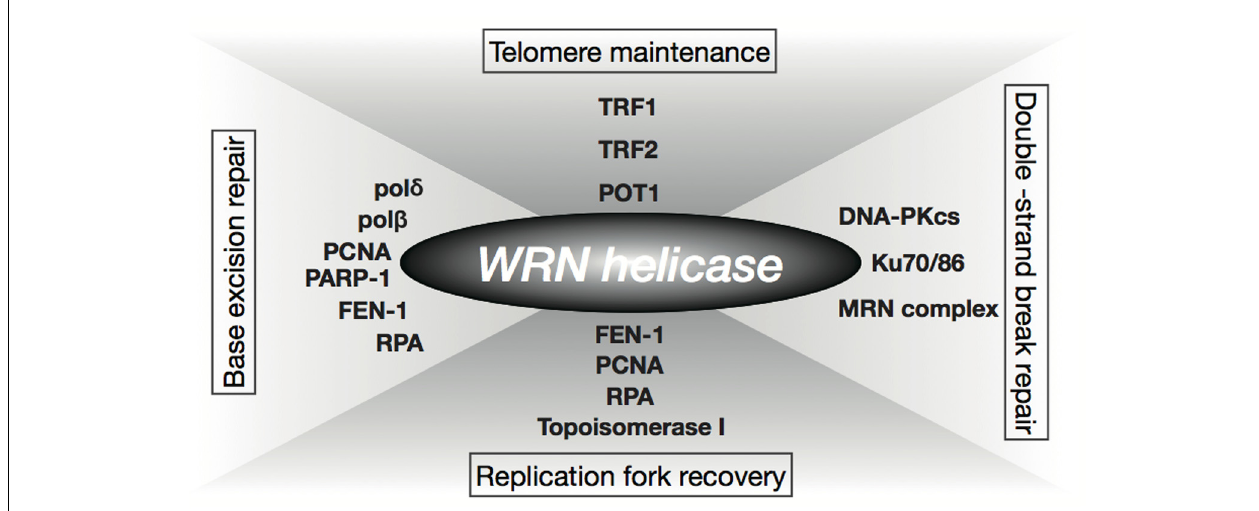
FIGURE 1 | Function ofWRN helicase. WRN helicase functions through interaction with factors involved in replication (RPA, PCNA, FEN-1,Topoisomerase I), base excision repair (BER; pol δ , pol β , PCNA, RPA, FEN-1, PARP-1), double-strand break repair (Ku, DNA-PKcs, Mre11-Rad50-Nbs1 complex), and telomere maintenance, (TRF1,TRF2,